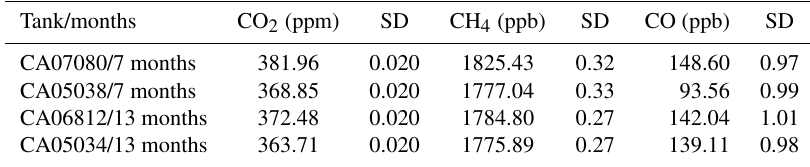
Table 6. Statistics for the target gas injections (30s mean assignments): mean and SD for the different species.